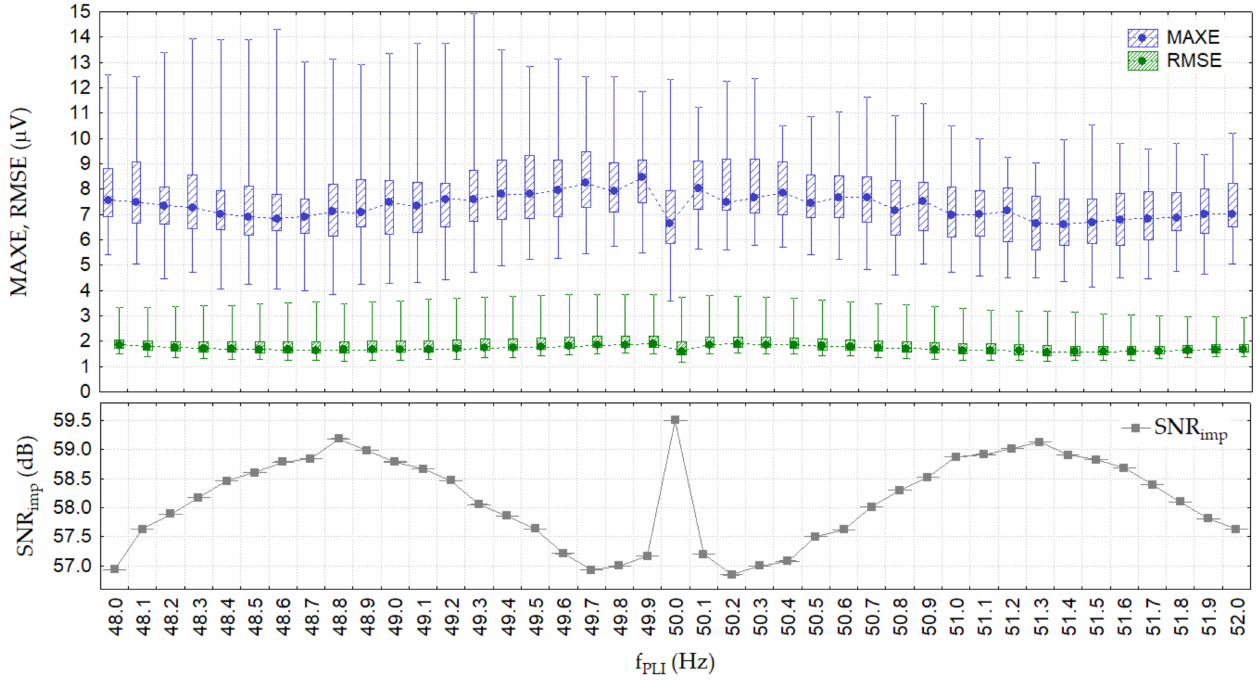
Figure 11. SF algorithm performance for PLI constant (frequency test), computed for 10 s with the PTB Diagnostic ECG database (lead II) and added PLI sinusoid with settings according to Table 2 (Test 2). The boxplots present MAXE, RMSE, and SNR imp statistical distributions (median; box: 25–75%; whisker: